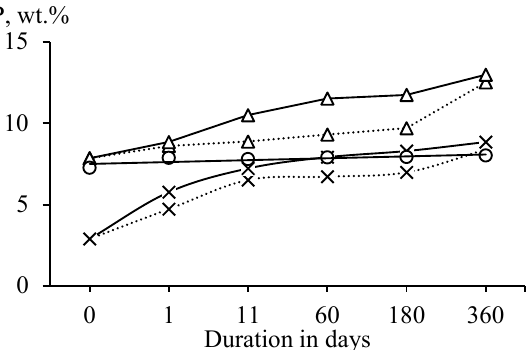
Figure 3. Dependence of the water content P (wt.%) in samples of heat-treated antigorite ( ○ ), lizard ‐ ite (×), and chrysotile ( Δ ) on the duration of exposure at a temperature of 20 ± 2 °C and a relative score of 95 ( ___ ) and 75% ( ‧‧‧‧ ).